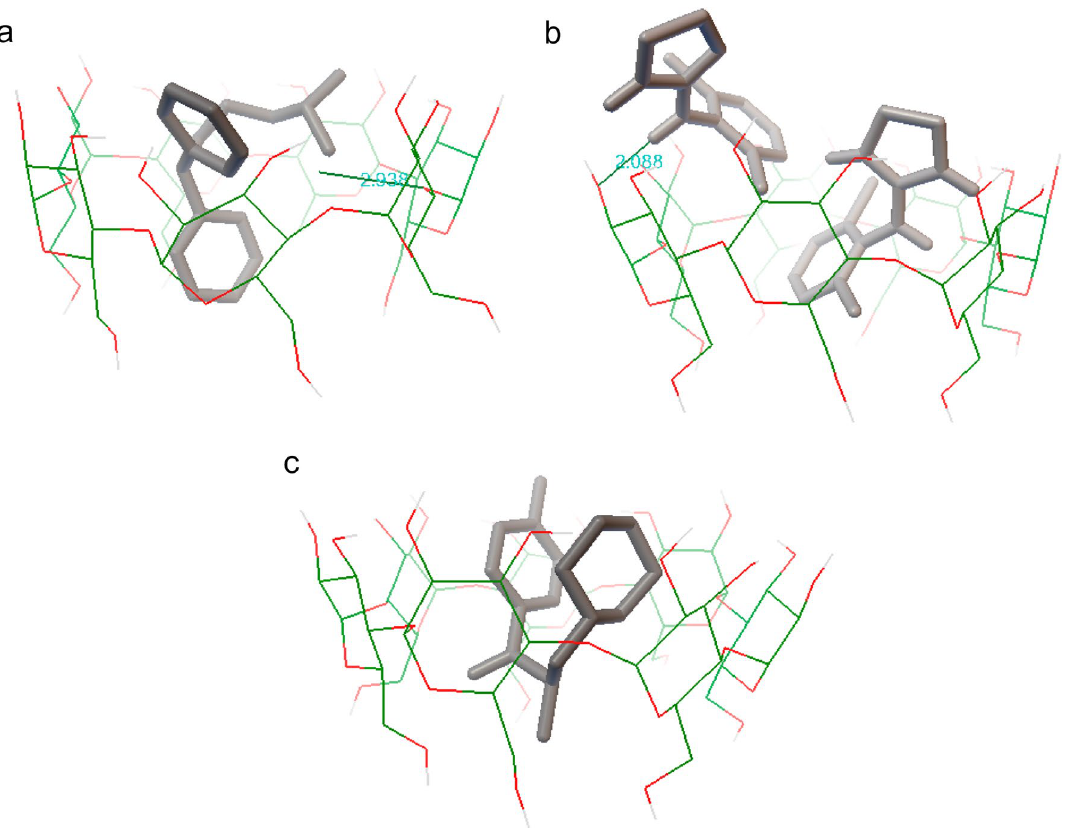
Fig. 6 Possible structures with lowest docked energies of the inclusion complex between β-CD and ( a ) diphenhydramine (1:1); ( b ) clonidine (1:2); ( c ) tolperisone (1:1). Drawn in AutoDock